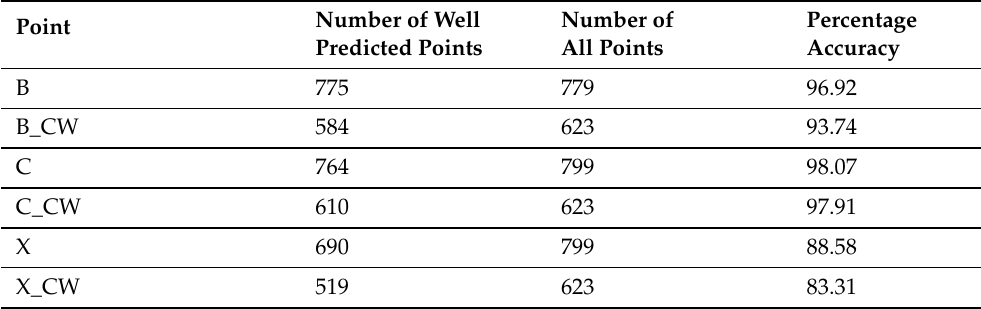
Table 5. The accuracy of characteristic point estimation via EMD-based algorithm. The comparison of the location of points estimated by an expert with the values determined by formulas based on IFMs. As matched locations for the expert and the algorithm, values differing by a maximum of ± 7 points—approximately 30 milliseconds—were